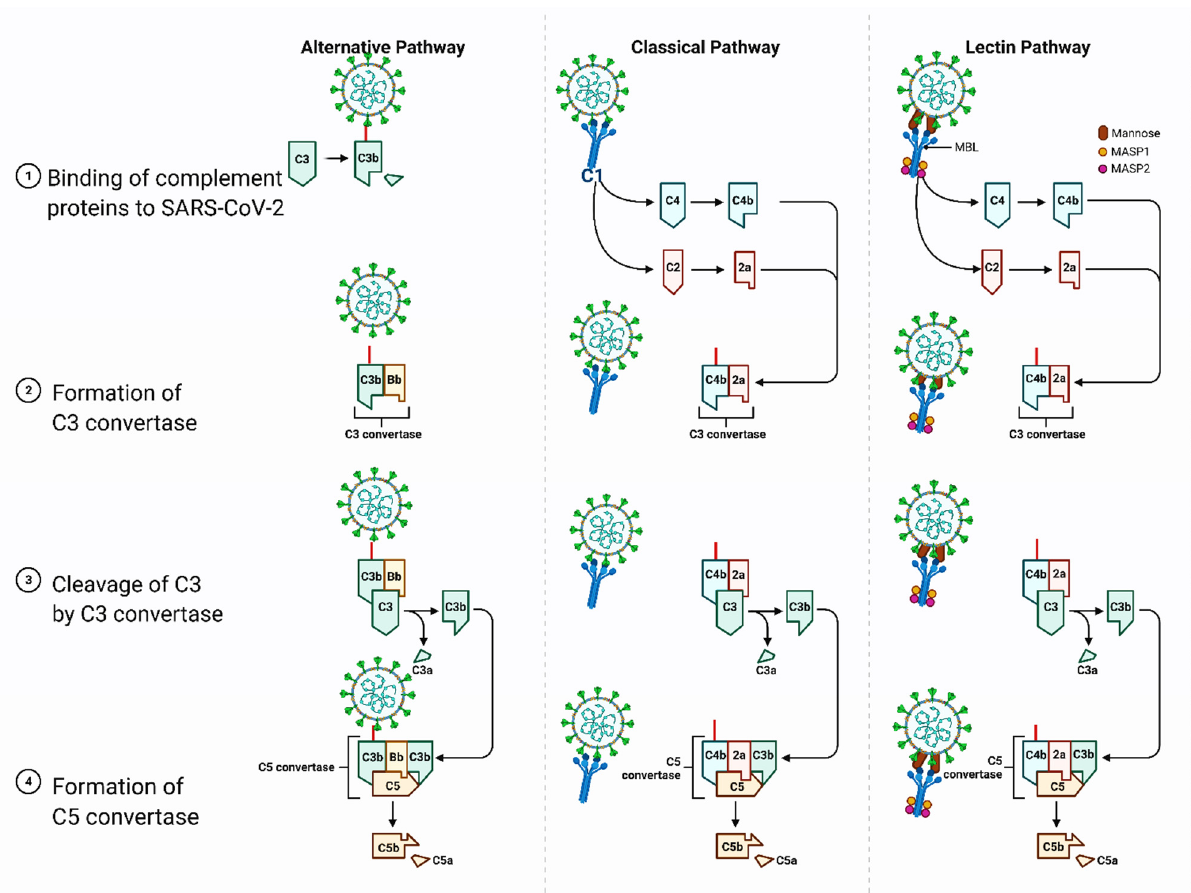
Figure 2. Potential Mechanisms for Upregulation of Complementary Pathways by the SARS-CoV-2 S Protein. Schematic presentation of the stages for alternative, classic and lectin pathways: 1 . Binding of complement proteins to SARS-CoV-2; 2 . Formation of C3 convertase; 3 . Cleavage of C3 by C3 convertase; 4 . Formation of C5 convertase. Figure was created with